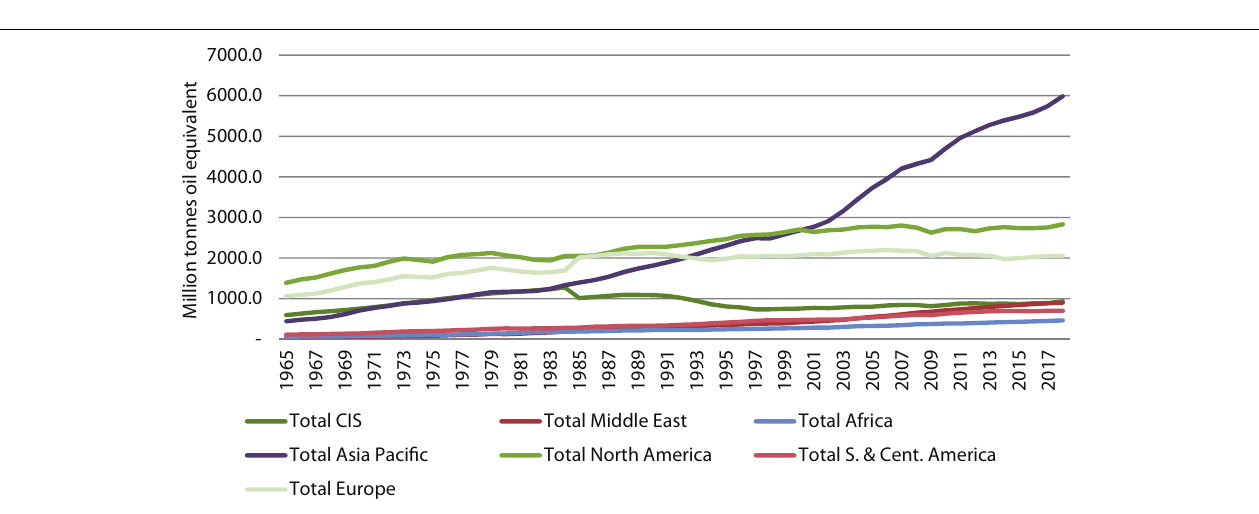
FIGURE 2 | Primary energy consumption in different regions, 1965–2018. CIS stands for Commonwealth of Independent States, Source: Compiled by the authors using BP’s 2019 statistical report.